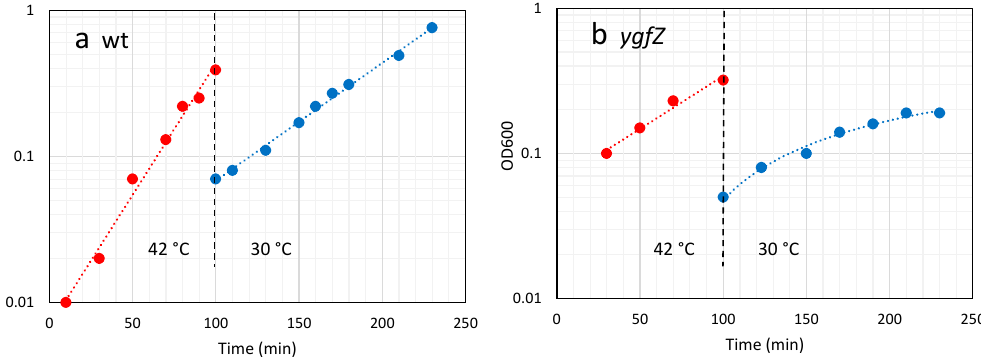
Figure 2. Growth curves for 42 → 30 °C experiments. The cultures were diluted and shifted at the time 100 min. Symbols: red 42 °C; blue 30 °C. ( a ) wt strain; ( b ) ygfZ mutant.